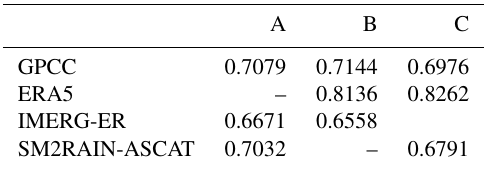
Table 2. Triple-collocation correlation obtained by using triplet